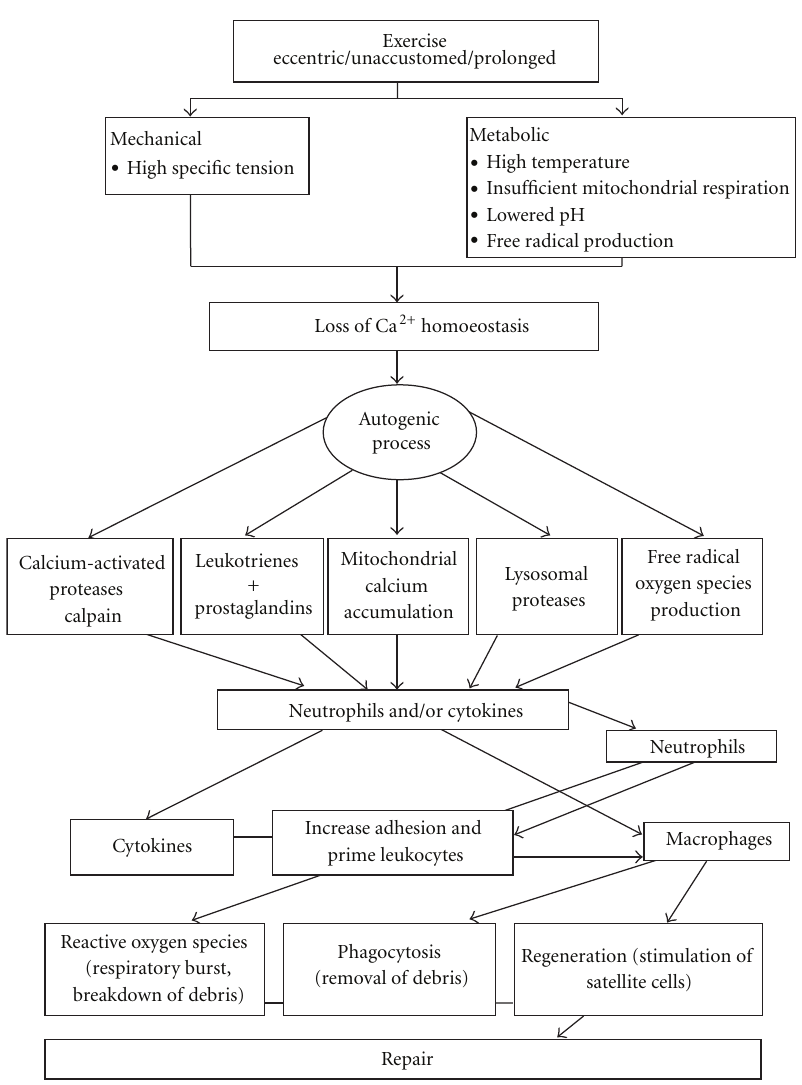
Figure 2: Theoretical model of muscle damage and repair cycle reproduced from Kendall and Eston